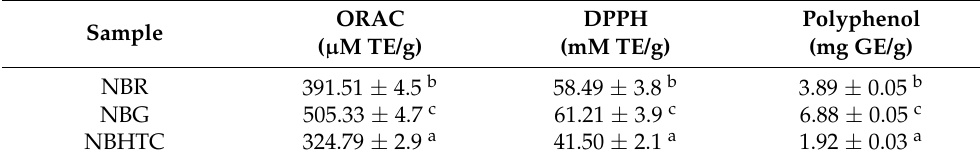
Table 7. Antioxidant activity of raw, germinated and hydrothermally cooked Nitta bean flour. Sample